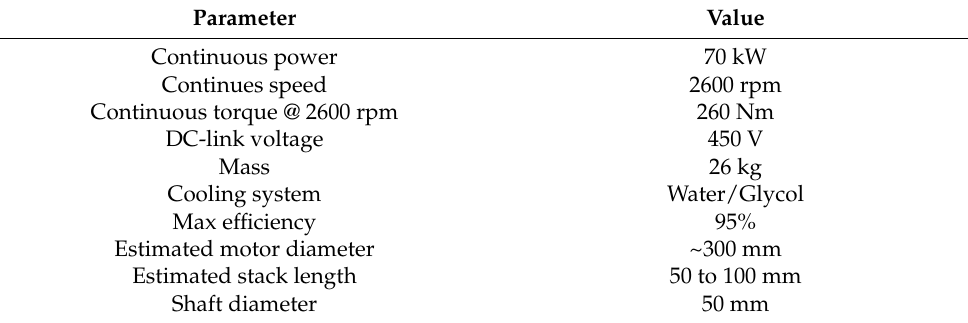
Table 1. Specification of SP70d PMSM [19].